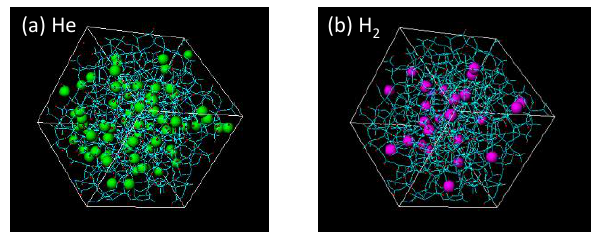
Figure 7. Snapshot of the distribution of sorption sites for probing: ( a ) helium and ( b ) hydrogen.